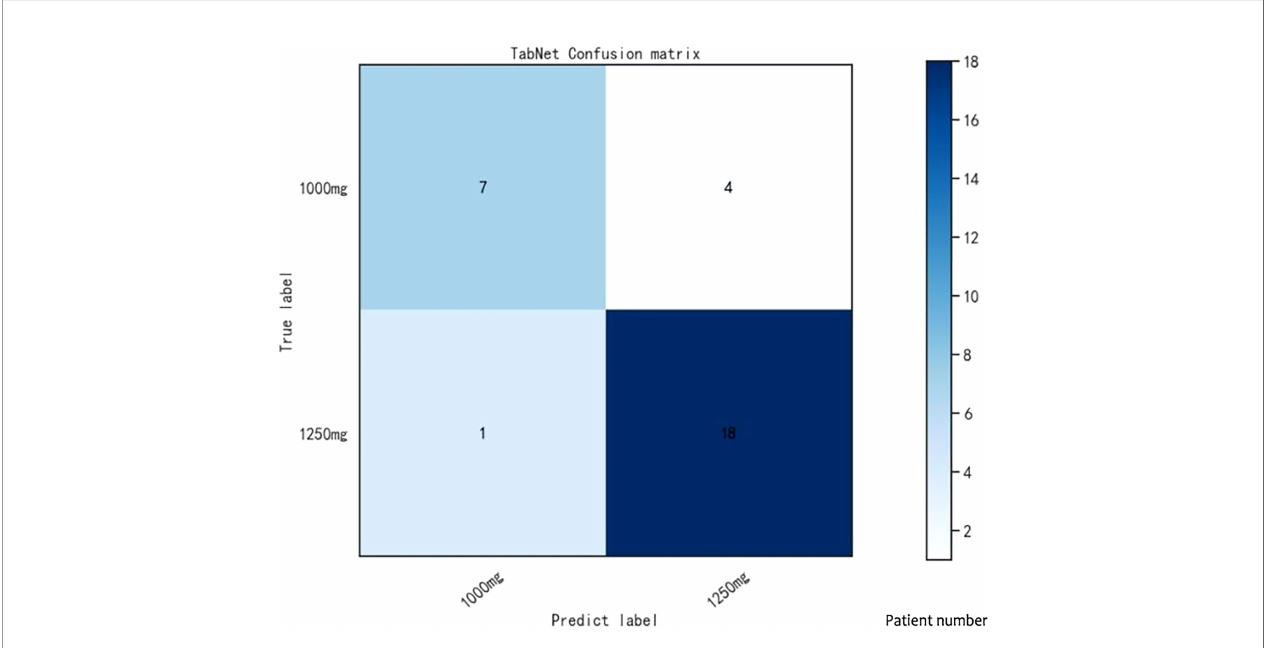
FIGURE 3 | Confusion matrix in TabNet